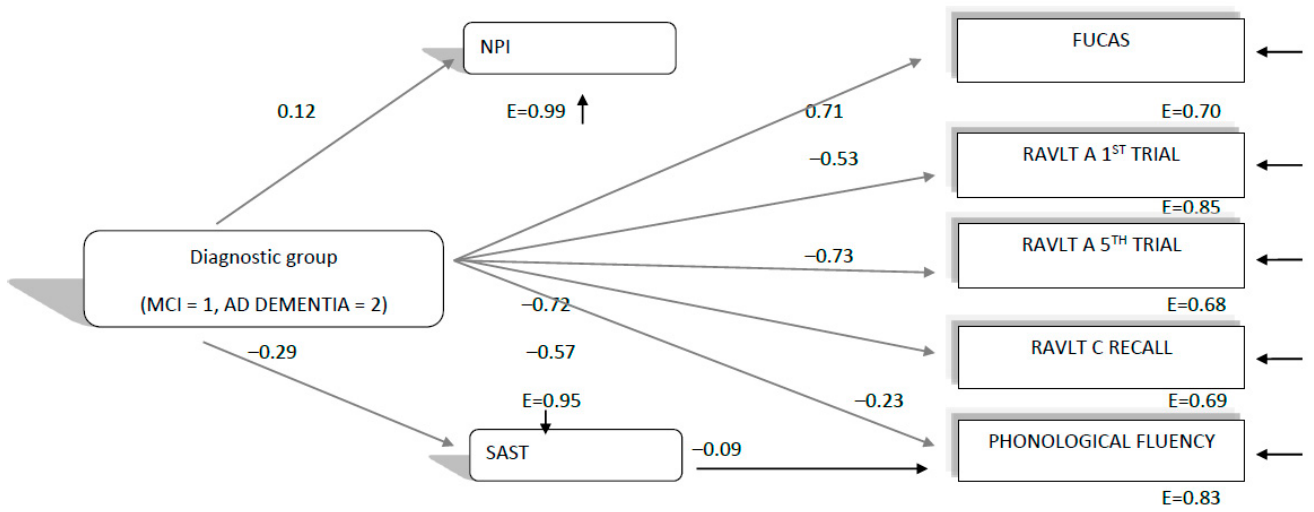
Figure 3. Direct and indirect relationships of diagnostic group (MCI, ADD) and negative affect (NPI, SAST) variables with everyday functioning and cognitive variables, which were found to decline faster between 2019 and 2020 measurements than between 2018 and 2019, as measured in the 2018 neuropsychological assessment. All relationships are significant at the p < 0.05 level. E = measurement error. All everyday functioning and cognitive variables were found to correlate significantly ( p < 0.05) between each